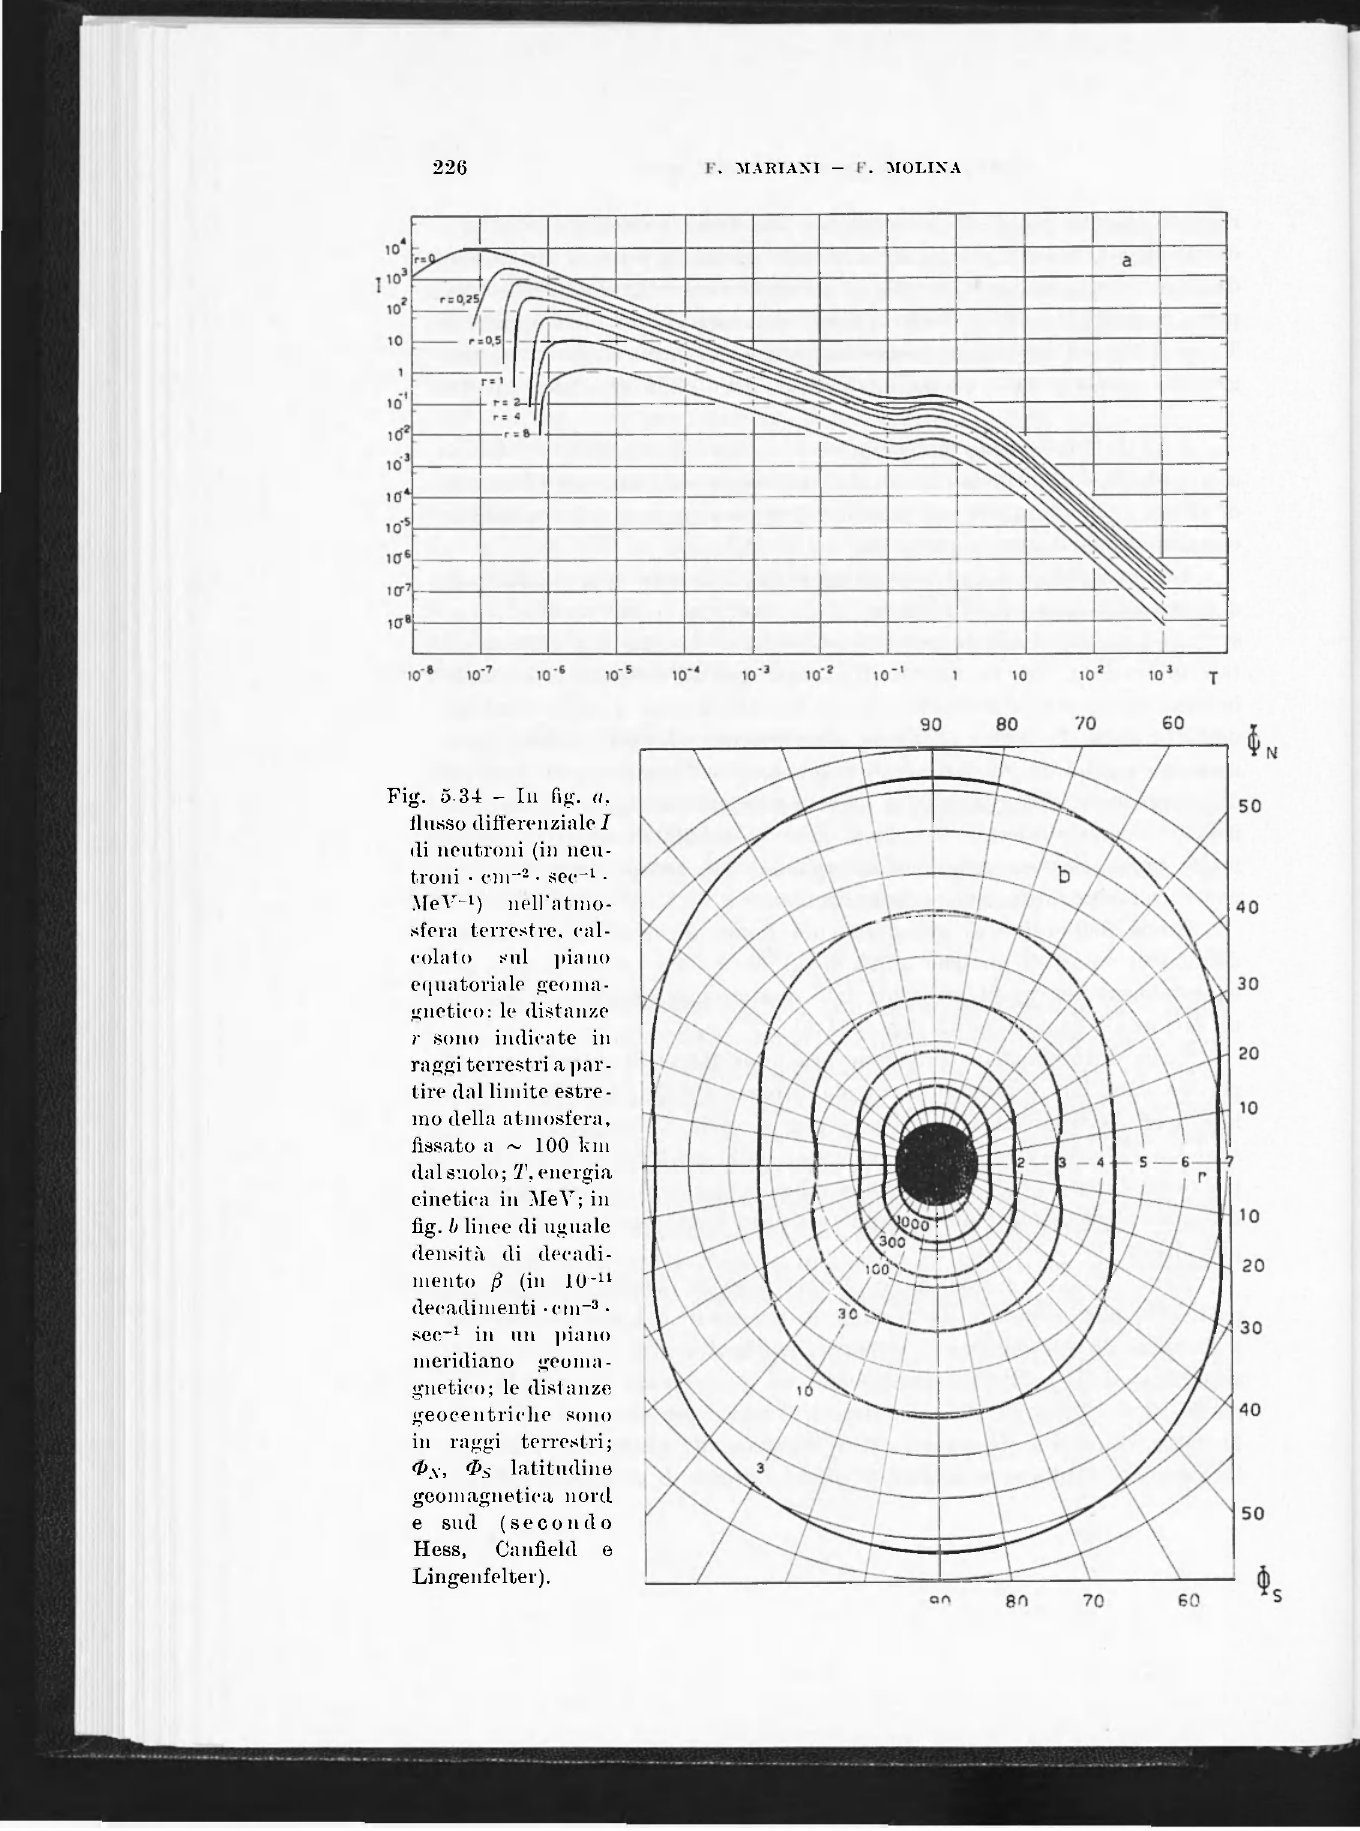
flusso differenziale